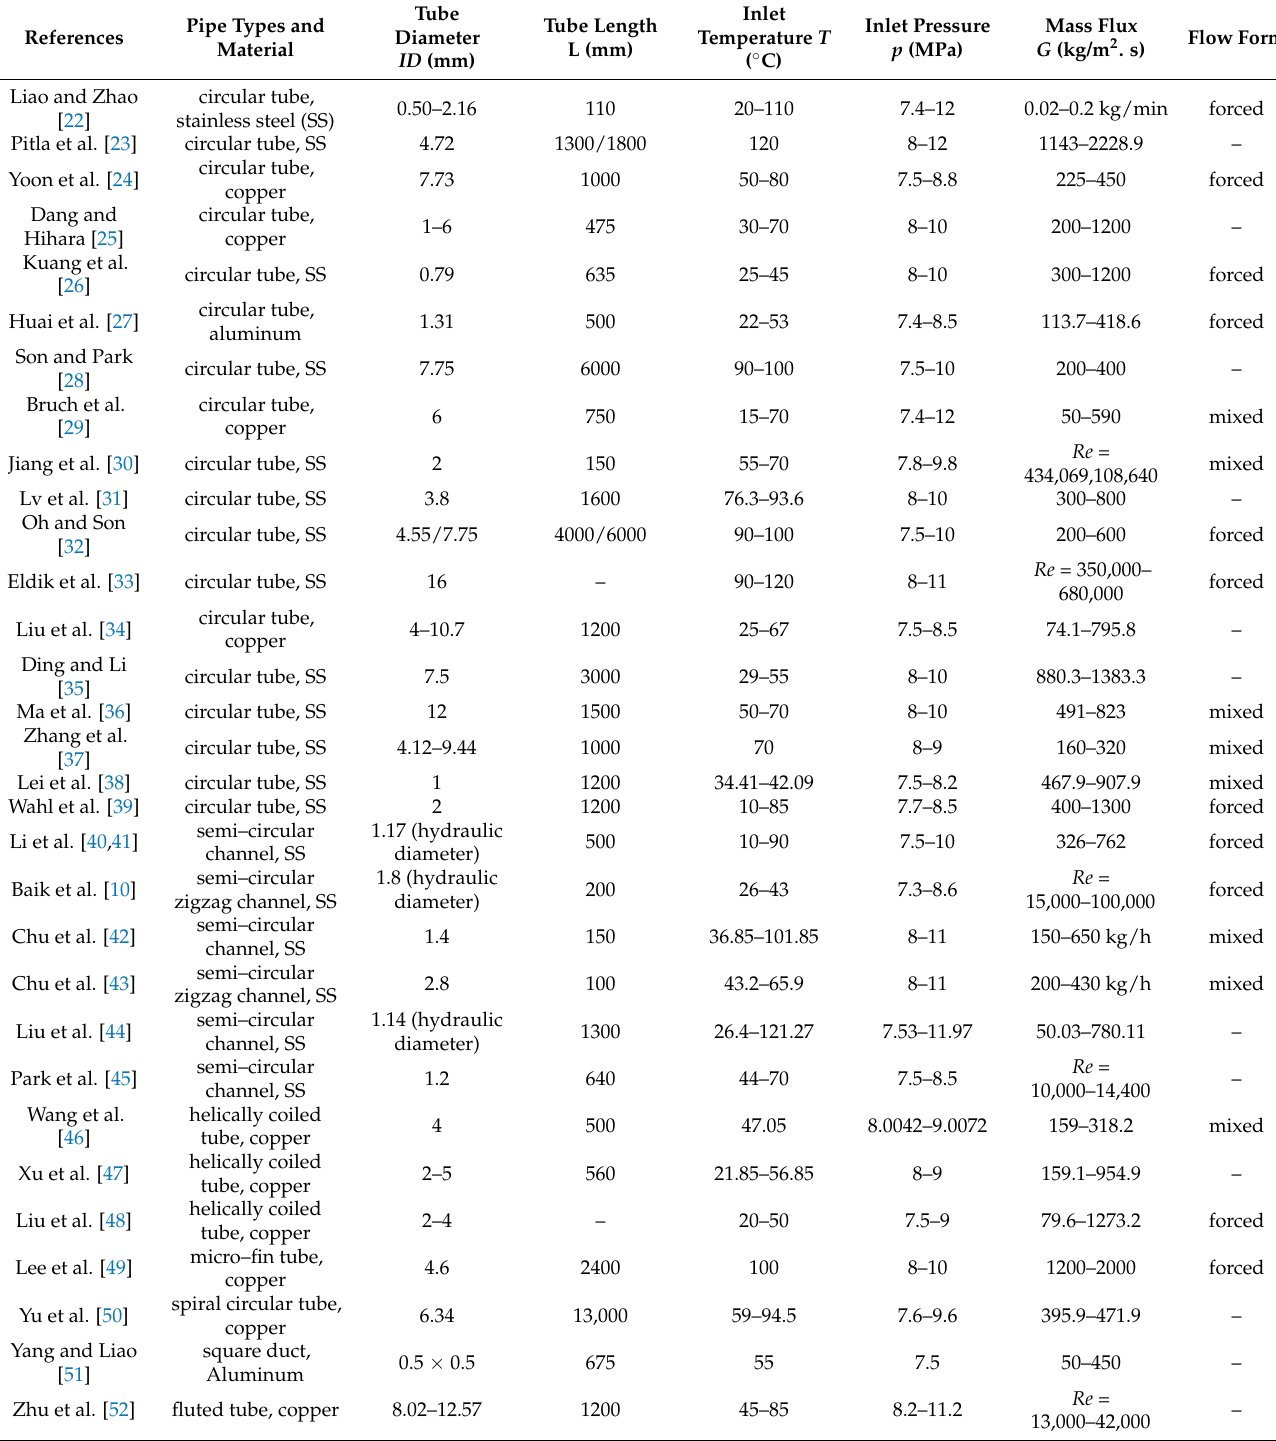
Table 1. Heat transfer experiments under SCO 2 cooling